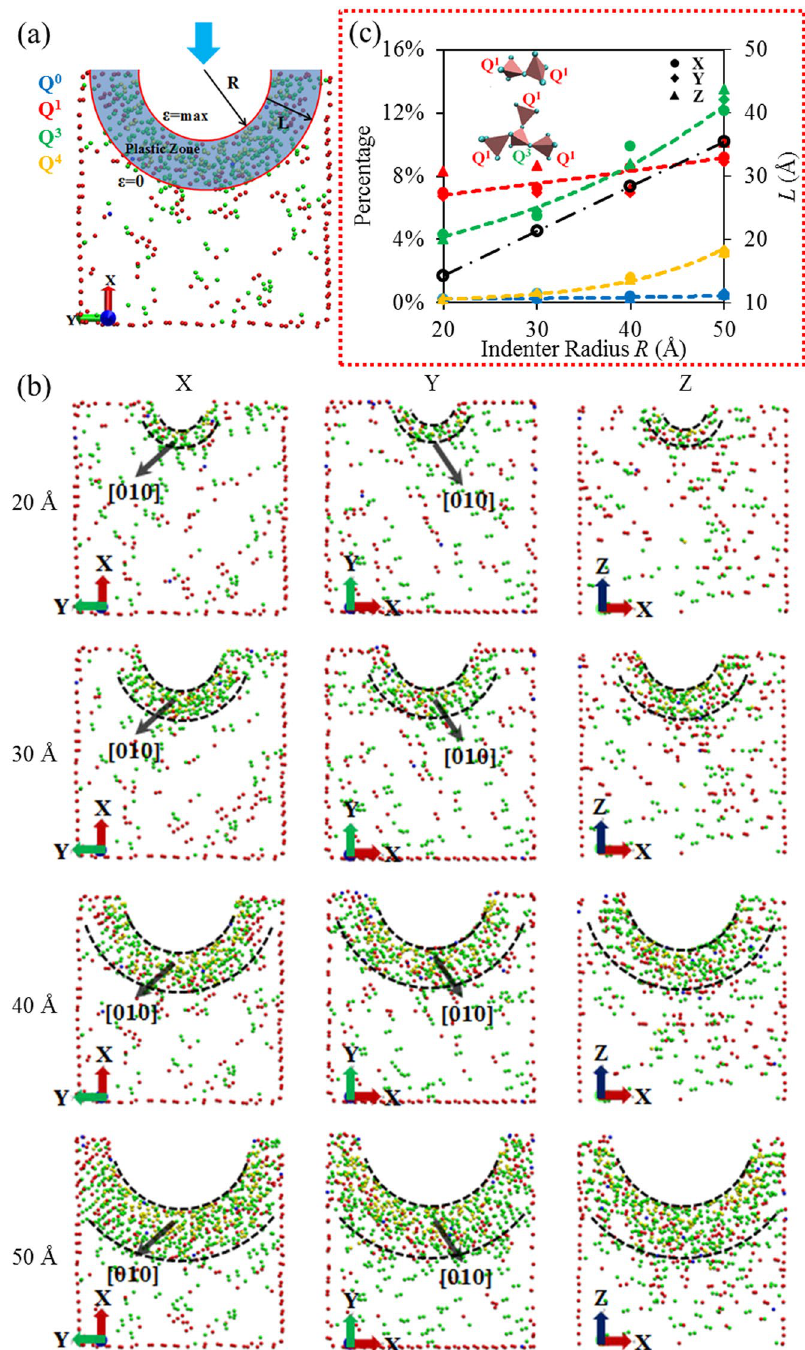
Figure 5. ( a ) Phase transformation in the plastic zone during nano-indentation with a 40 Å radius indenter depressing along X axis. ( b ) Side cross-sectional view of the indented structure with different indenter size depression along each direction. ( c ) The comparison of Q 0 , Q 1 , Q 3 , Q 4 of the indented structure with different indenter size depression along each direction (colored curves corresponding to the left ordinate); and the linear relationship between L and R (black line corresponding to the right